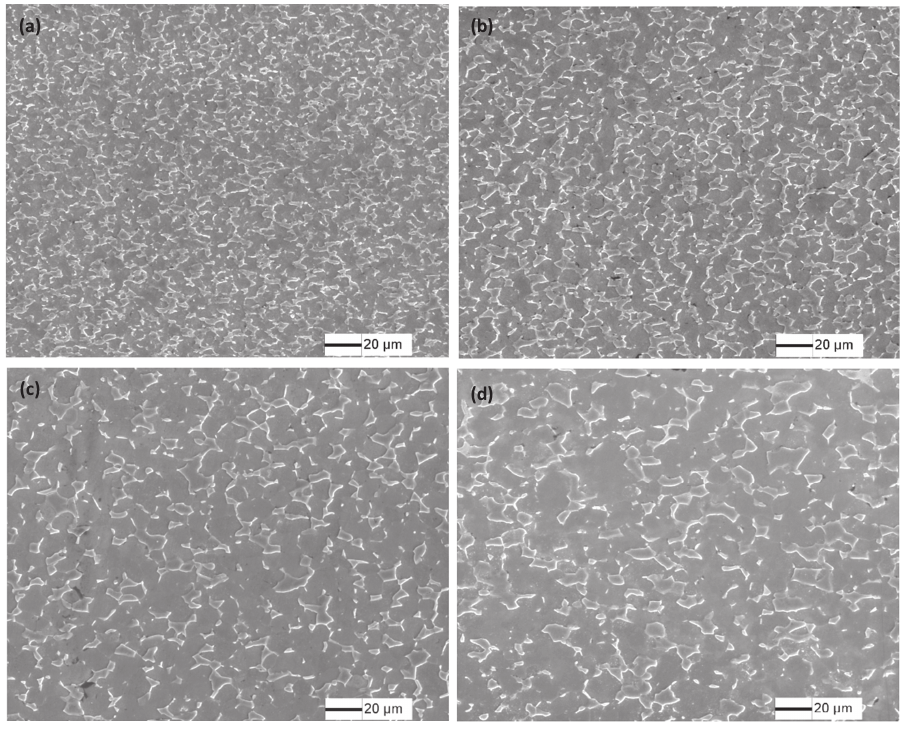
Figure 7: Ti-6Al-4V microstructures near fracture surface after hot tensile deformation (a) 3.0 mm/min,